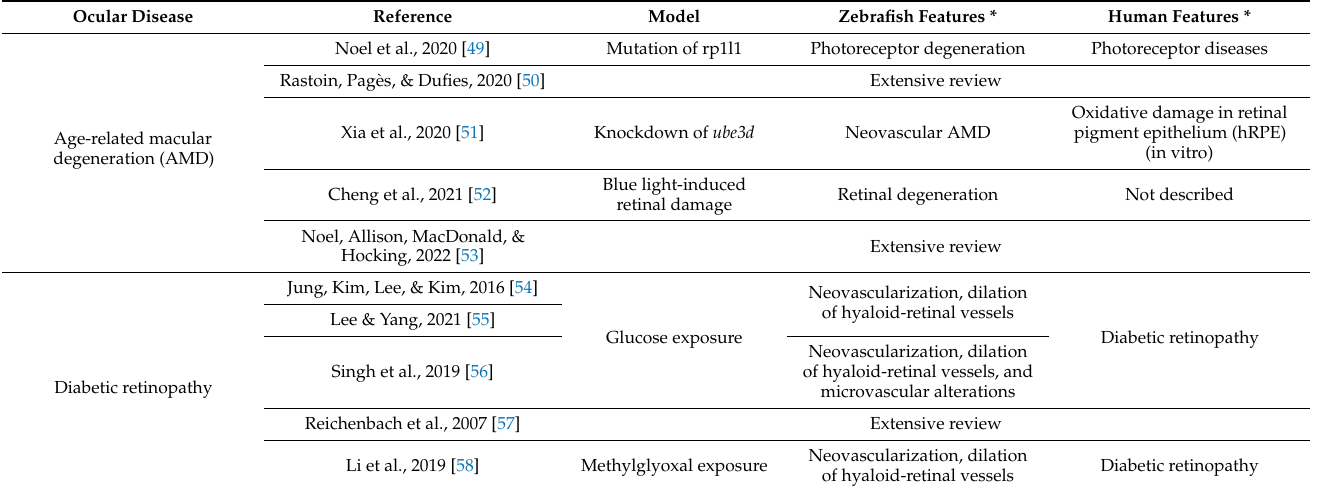
Table 2. Defects of the Posterior